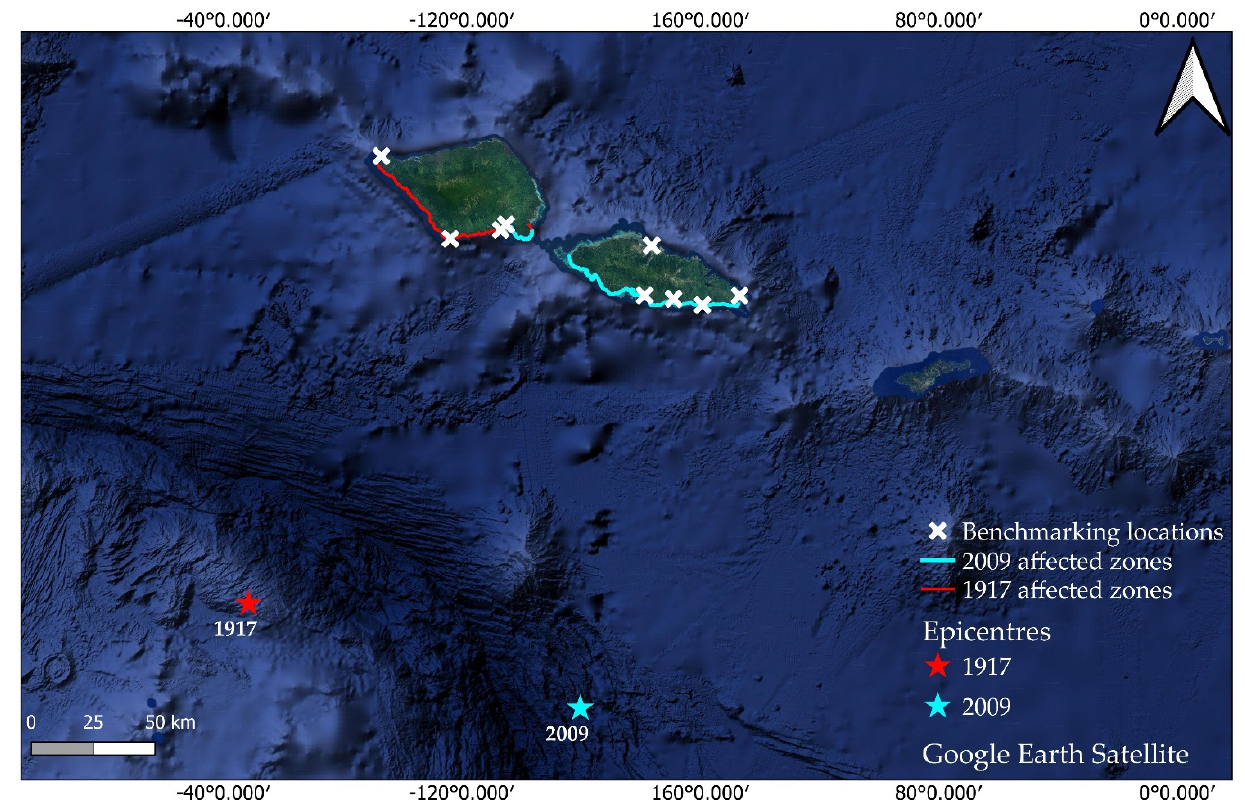
Figure 10. Epicentres of the 1917 and 2009 earthquakes and corresponding extents at the coast that were predominantly affected by each respective tsunami according to the models. The red crosses indicate the 1917 runup benchmarks shown in Figures 5 and 6 showing locations that should be inundated.